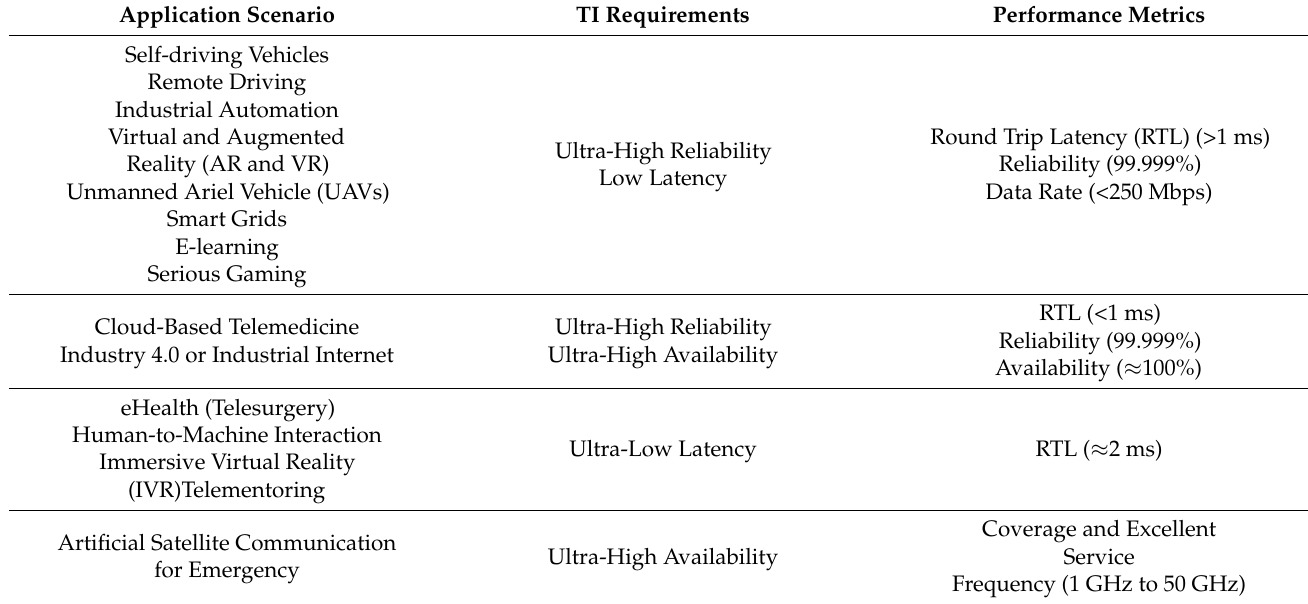
Table 4. TI applications based on 5G